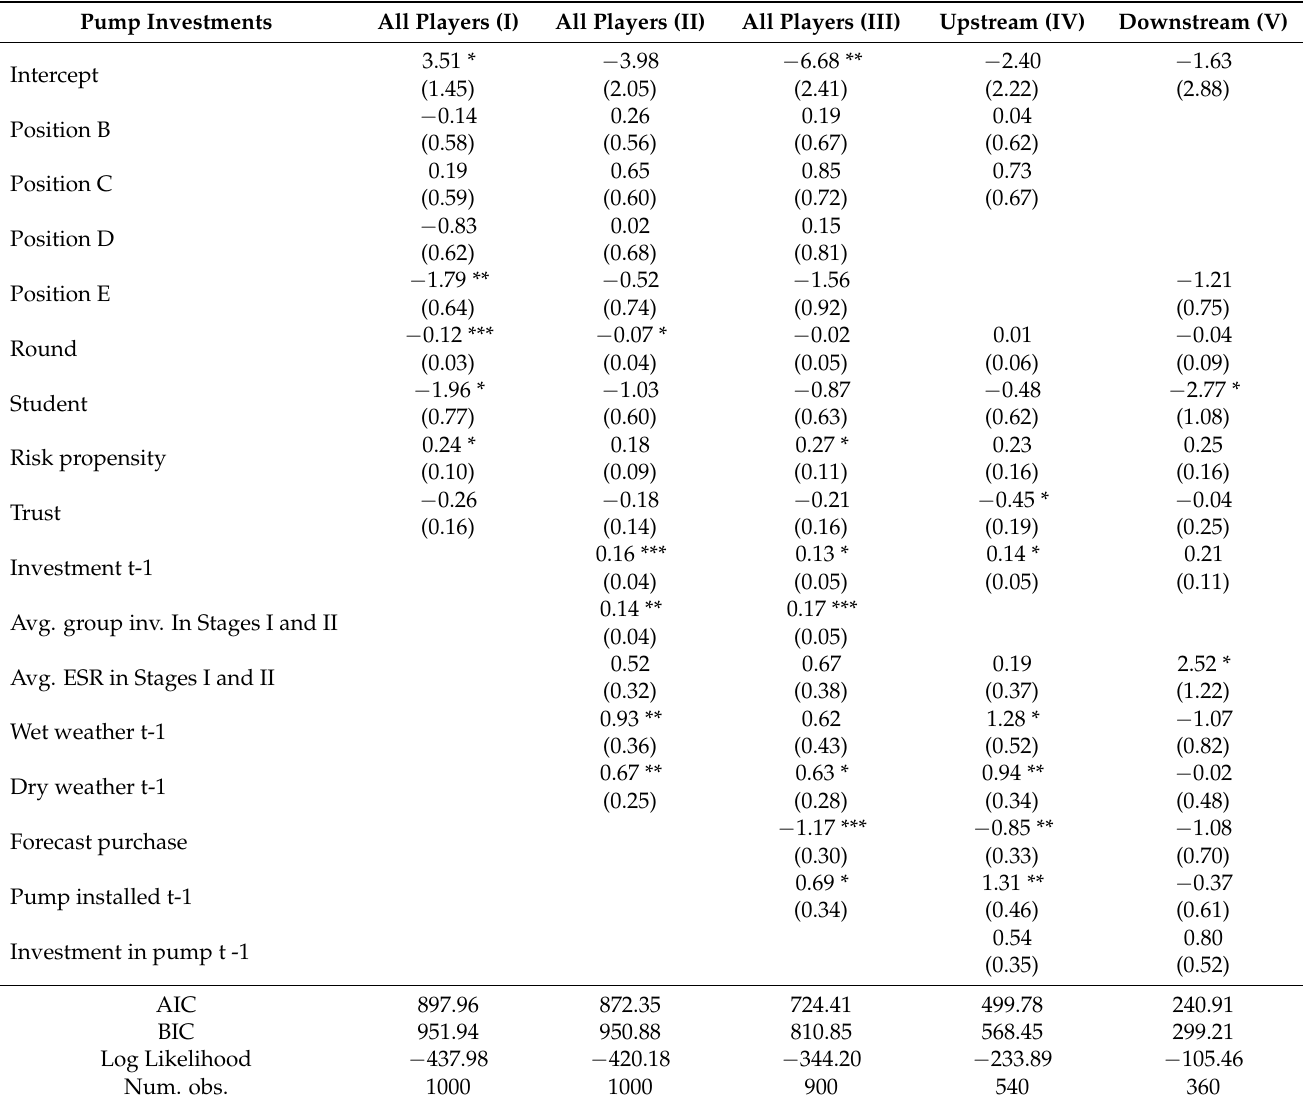
Table 4. Logistic regression results for individual investments in pump